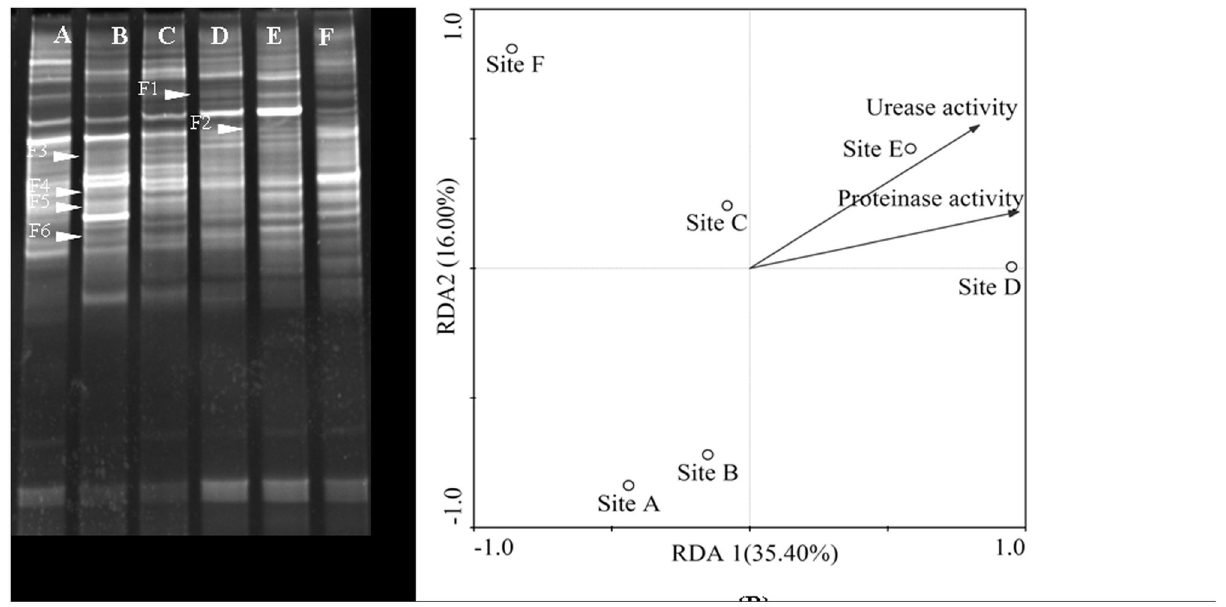
Figure 5. DGGE profiles of PCR-amplified 18S rRNA gene-internal transcribed spacer. (A) Fragments in a denaturing from 30% to 70% gradient gel. F1-F6 represents sequenced bands in the fungal community DGGE gel. (B)Redundancy Analysis (RDA) of fungal community in the sediments from each six sampling sites (site A, site B, site C, site D, site E, site F) in the Zhou cun drinking water reservoir, eastern China. Samples are represented by open circles and capital letters refer to the sampling sites. Numbers in brackets represent the percentage of variation explained by each factor, RDA1 explains 35.40% of the variance of the data and RDA2 explains 16.00% of the variance in the data, respectively. Significant factors for variation extracted from environmental data (sediment urease and protease activity) are given as vectors. doi: